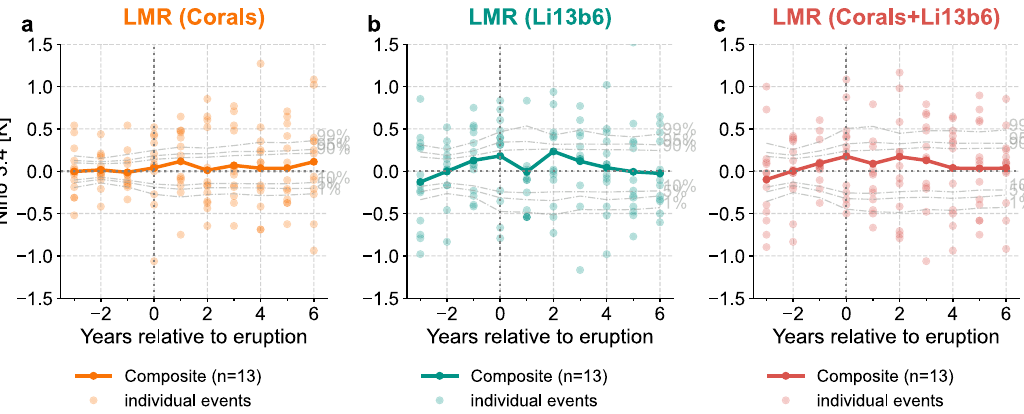
Fig. 3 Superposed epoch analysis (SEA) of the last millennium reanalysis (LMR) 31,32 Niño 3.4 reconstructions around the 13 events when the Palmyra record is available. a coral predictors only, b Li13b6 predictors only, and c corals + Li13b6 predictors. Solid curves with dark dots denote the composite mean, and the light dots denote the Niño 3.4 anomaly at each year for each individual event. The light gray dashed curves denote the 1%, 5%, 10%, 90%, 95%, and 99% quantiles of the composite means from 1000 bootstrap draws from non-volcanic years (see “ Methods ” for details).